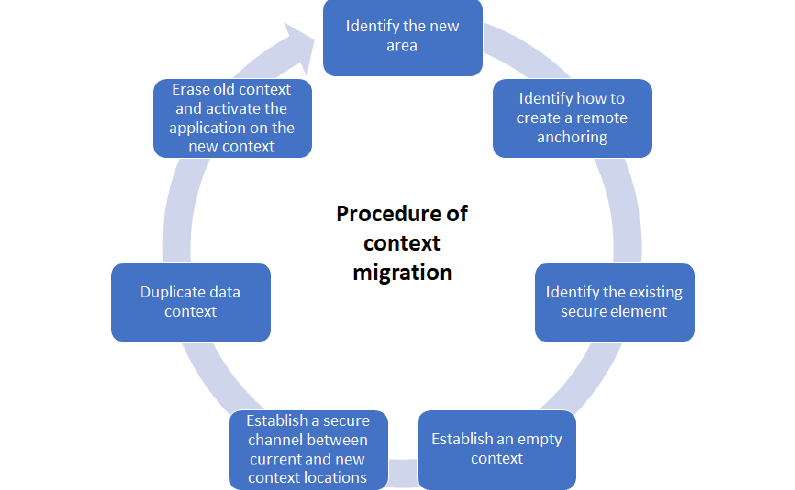
Figure 2. The life-cycle of the security context